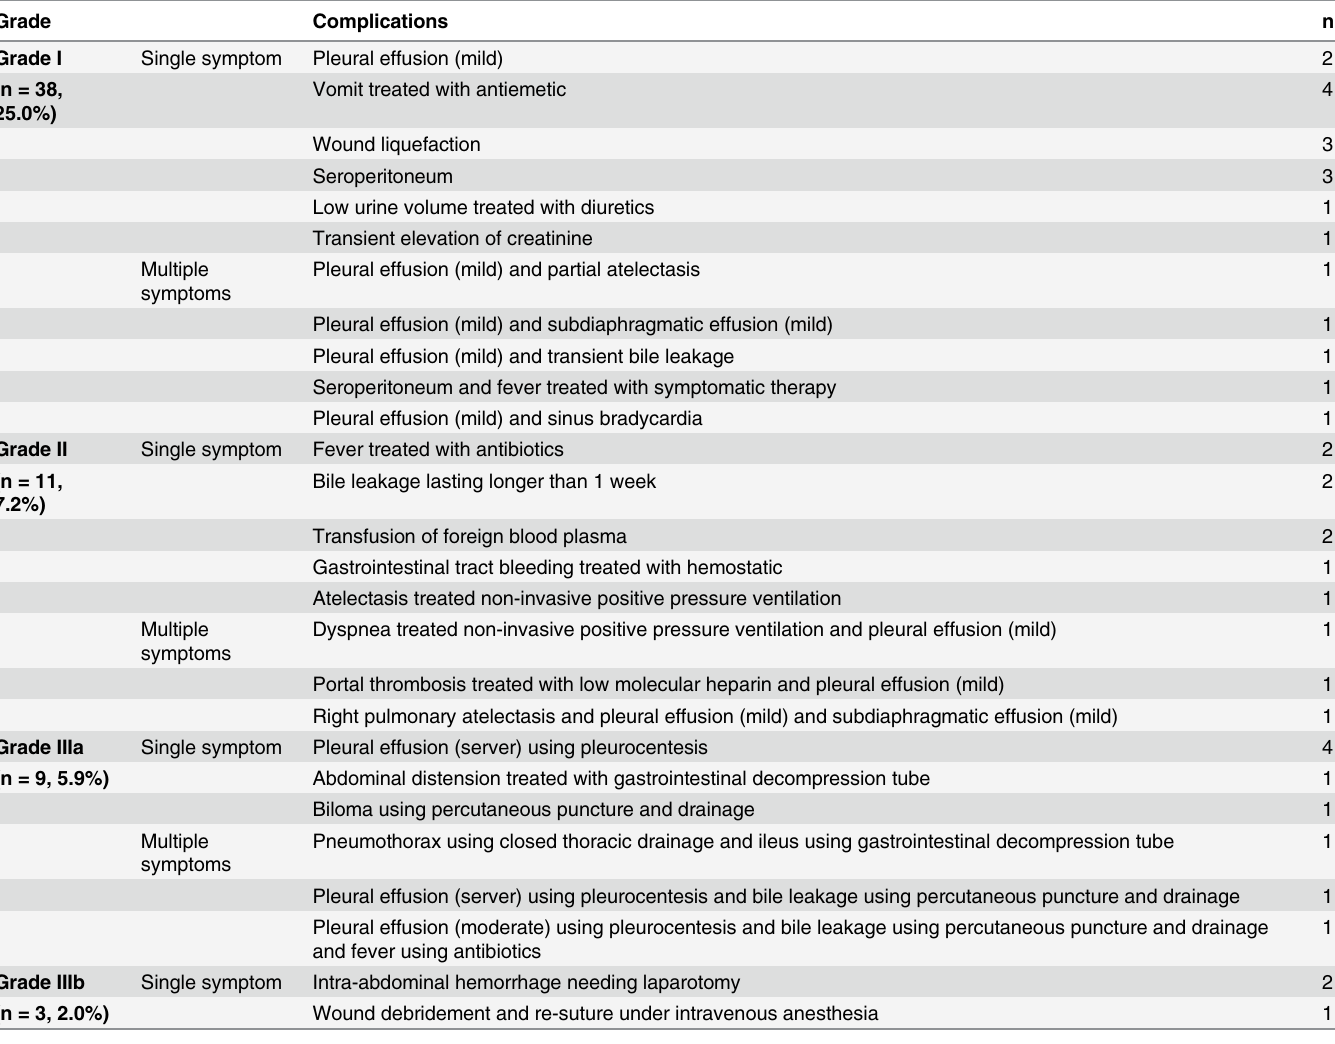
Table 3. Complications in liver donors according to the modified Clavien classification